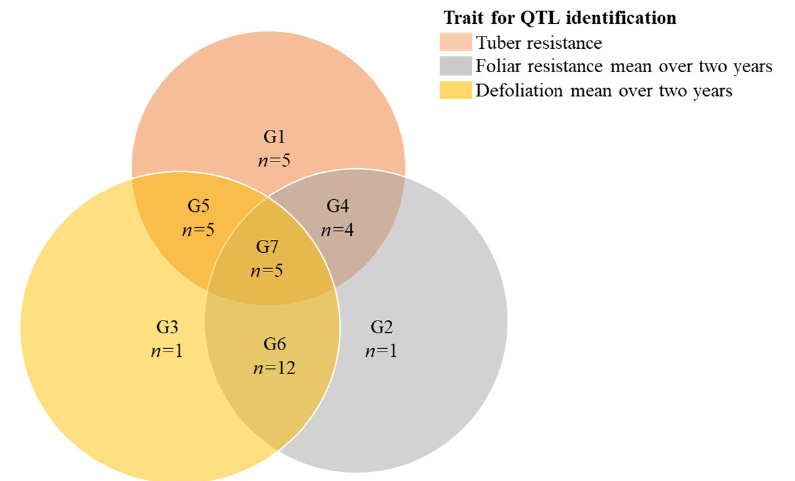
Figure 3. Venn’s diagram showing the seven different groups of predicted quantitative trait loci (QTL) for tuber resistance to early blight, mean foliar resistance to early blight over 2014 and 2016 and mean defoliation over 2015 and 2016. Grouping are created according to the probable dependency of the QTL, where a QTL can only be explained by a single trait (groups 1 to 3) if the area of the predicted QTL does not overlap with the area of a QTL predicted by another trait, and is not present on the corresponding chromosome from the other parental linkage map. QTL in groups 4 to 6 are possibly overlapping (dependent) on two phenotypic traits. Group 7 contains QTL that could not be declared independent in any of the three phenotypic